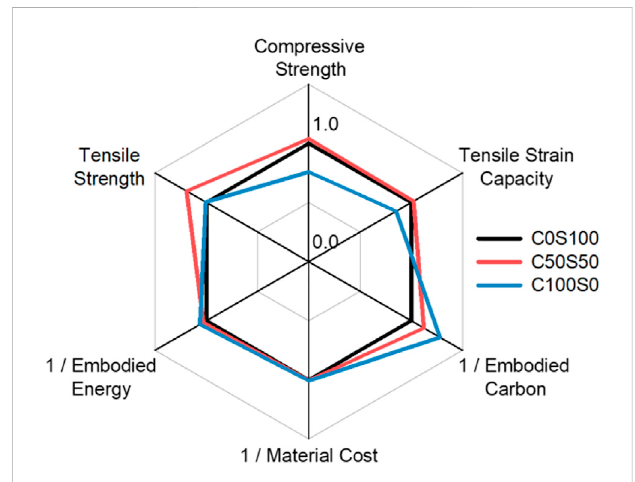
FIGURE 12 Overall assessment of SH-UHPGC considering mechanical performance, energy consumption, environmental impact, and material